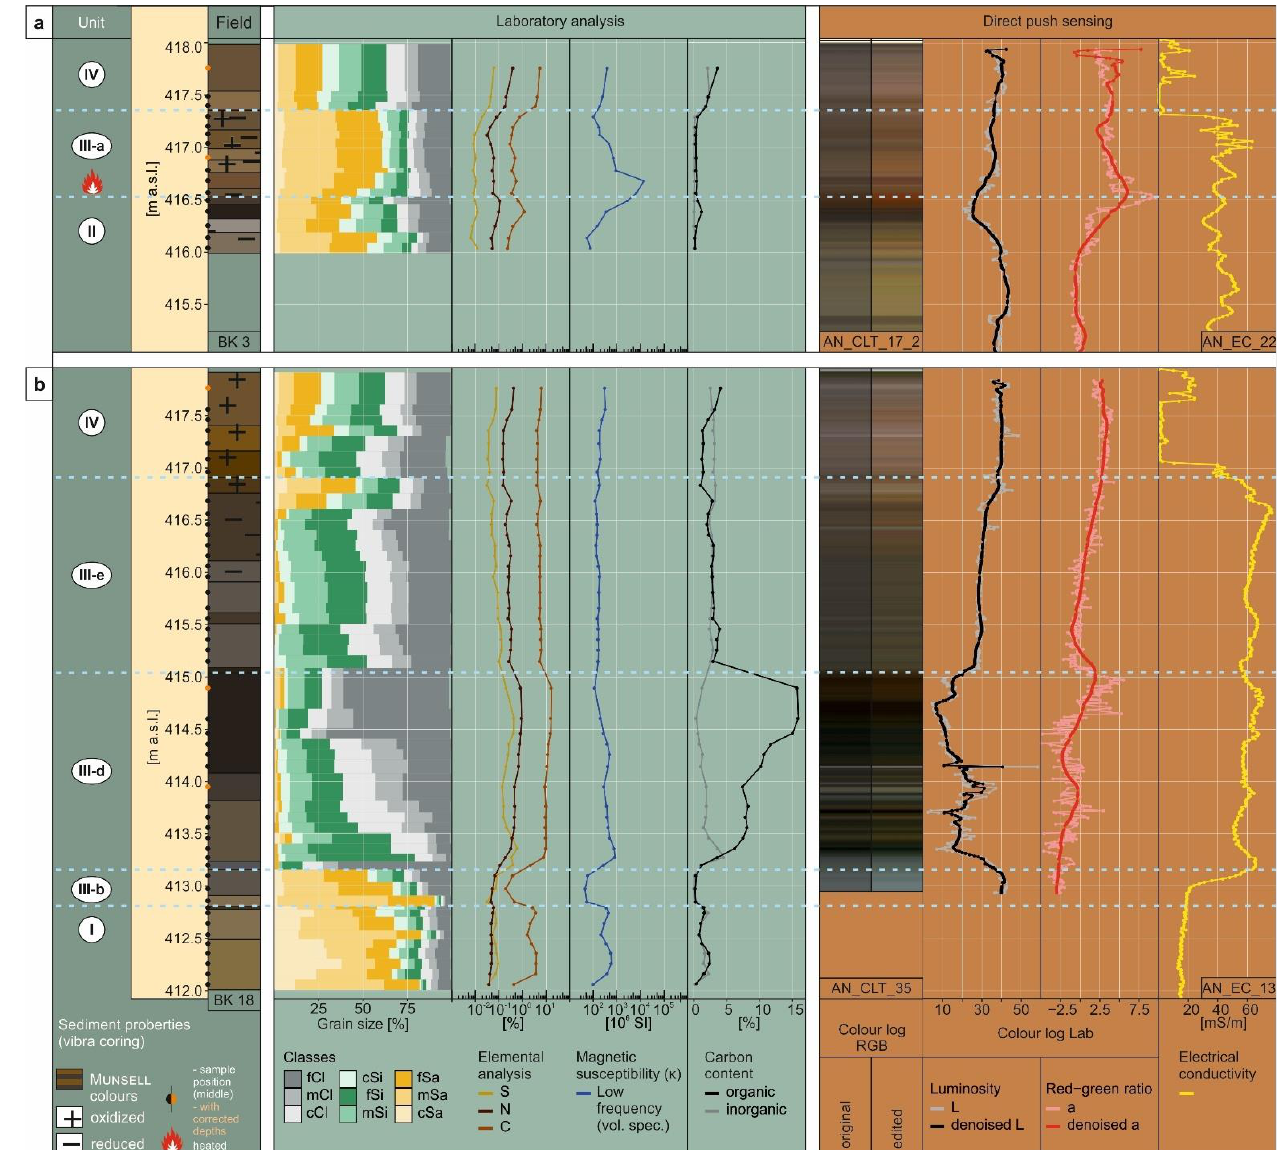
Figure 8. Laboratory results of analysis of the samples from core BK3 ( a ) and BK18 ( b ) compared with direct push sensing data. Within core BK 3, a magnetic mass anomaly is evidenced by the maximum of the magnetic susceptibility. Core BK18 is located at the centre of the canal. The core data were depth-corrected with reference to direct-push colour logs (Figure S1).